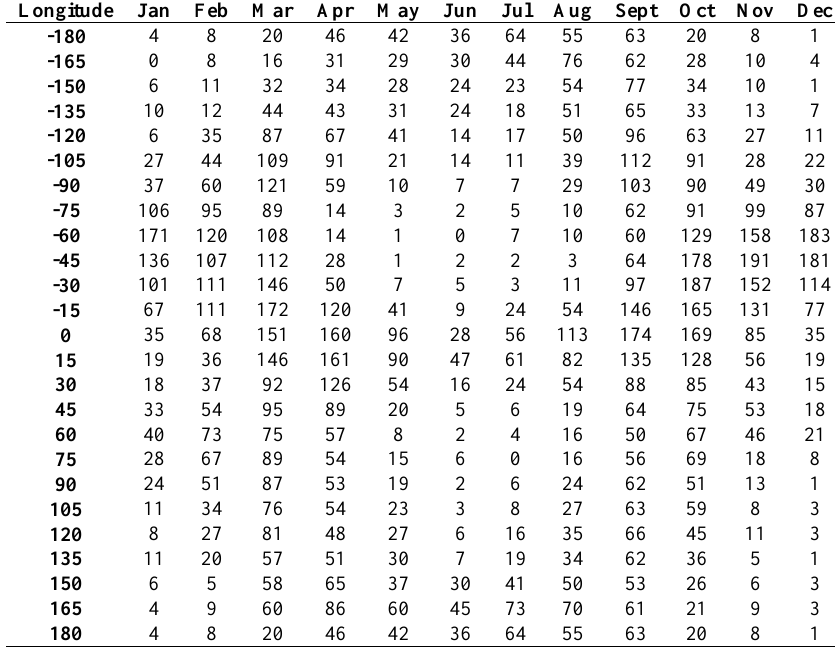
Table 3. Number of orbits with EPBs per month in each longitude sector for the full DMSP EPB database